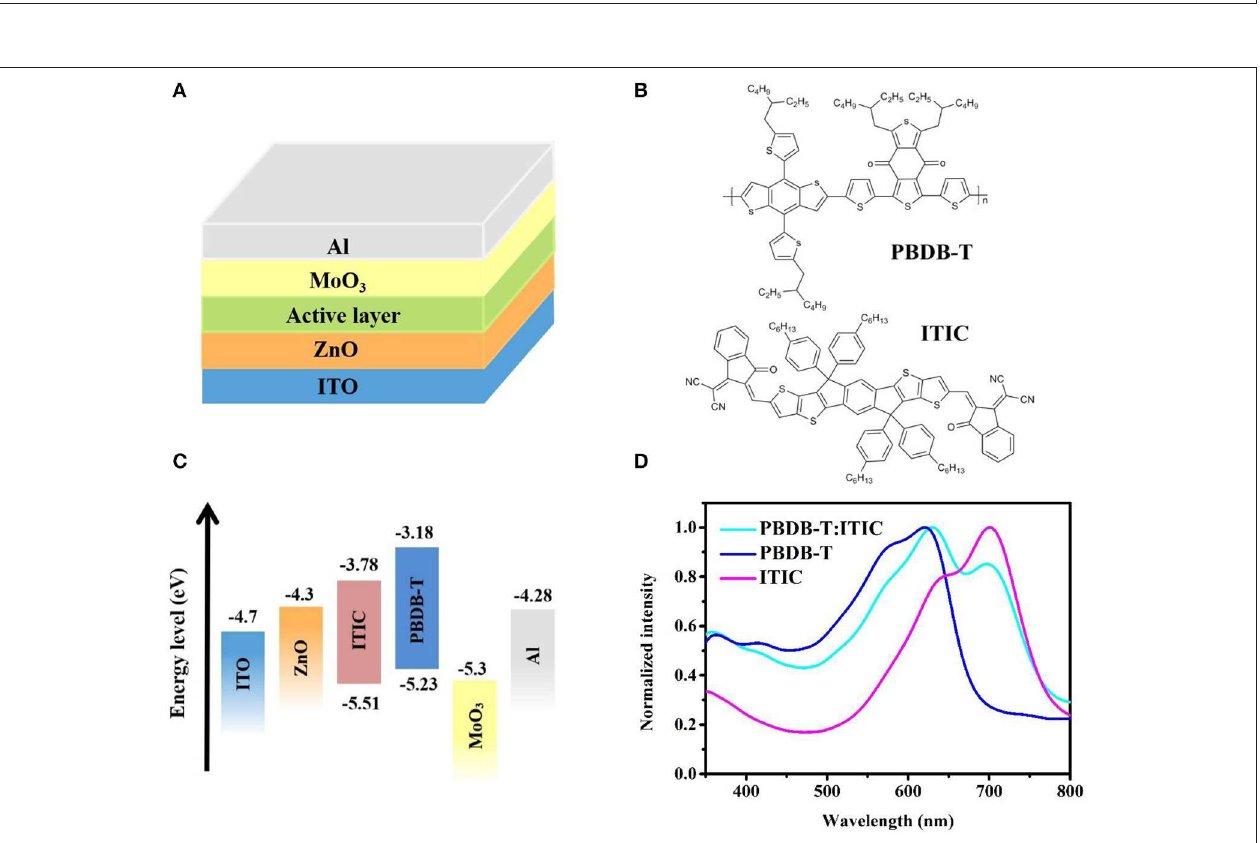
FIGURE 4 | (A) Inverted device structure of organic photovoltaic devices (OPVs) studied in this work. (B) Molecular structures of poly{(2,6-(4,8-bis(5-(2- ethylhexyl)thiophen-2-yl)-benzo[1,2-b:4,5-b ′ ]dithiophene))-alt-(5,5-(1 ′ ,3 ′ -di-2-thienyl-5 ′ ,7 ′ -bis(2-ethylhexyl)benzo[1 ′ ,2 ′ -c:4 ′ ,5 ′ -c ′ ]dithiophene-4,8-dione))} (PBDB-T) and 3,9-bis{2-methylene-[3-(1,1-dicyanomethylene)-indanone]}-5,5,11,11-tetrakis(4-hexylphenyl)-dithieno[2,3-d:2 ′ ,3 ′ -d ′ ]-s-indaceno[1,2-b:5,6-b ′ ]dithiophene (ITIC). (C) Energy level diagram of individual layers in OPVs. (D) Normalized absorption spectra of neat PBDB-T, neat ITIC, and PBDB-T:ITIC blend film.